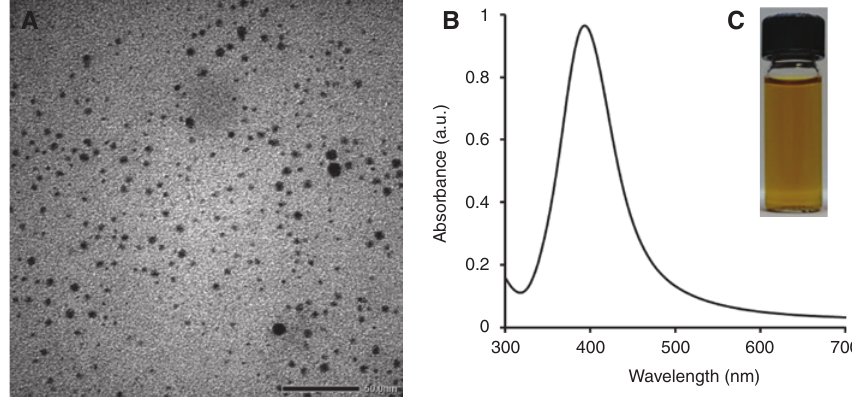
Figure 2: TEM image (A), UV-Vis absorption spectrum (B), and digital photograph (C) of Ag